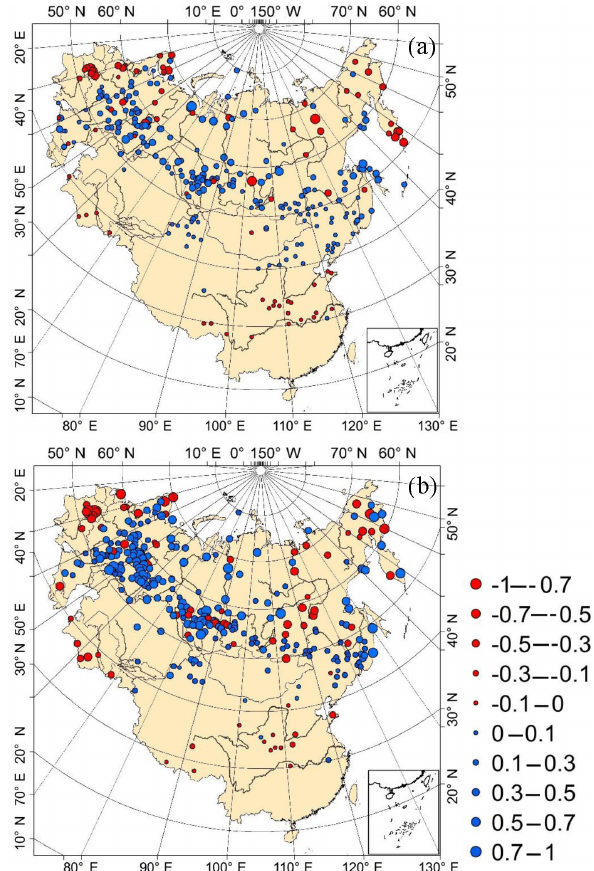
Figure 6. Spatial distribution of linear trend coefficients (cmyr − 1 ) of annual mean snow depth (a) and annual maximum snow depth (b) for each station in 1966–2012. The rate of change at the 95% level is displayed. Red circles represent a decreasing trend, and blue circles represent an increasing